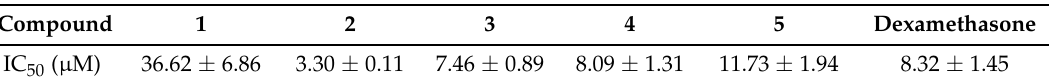
Table 2. IC 50 values of the compounds from A. szechenyianum on NO production in LPS-activated RAW264.7